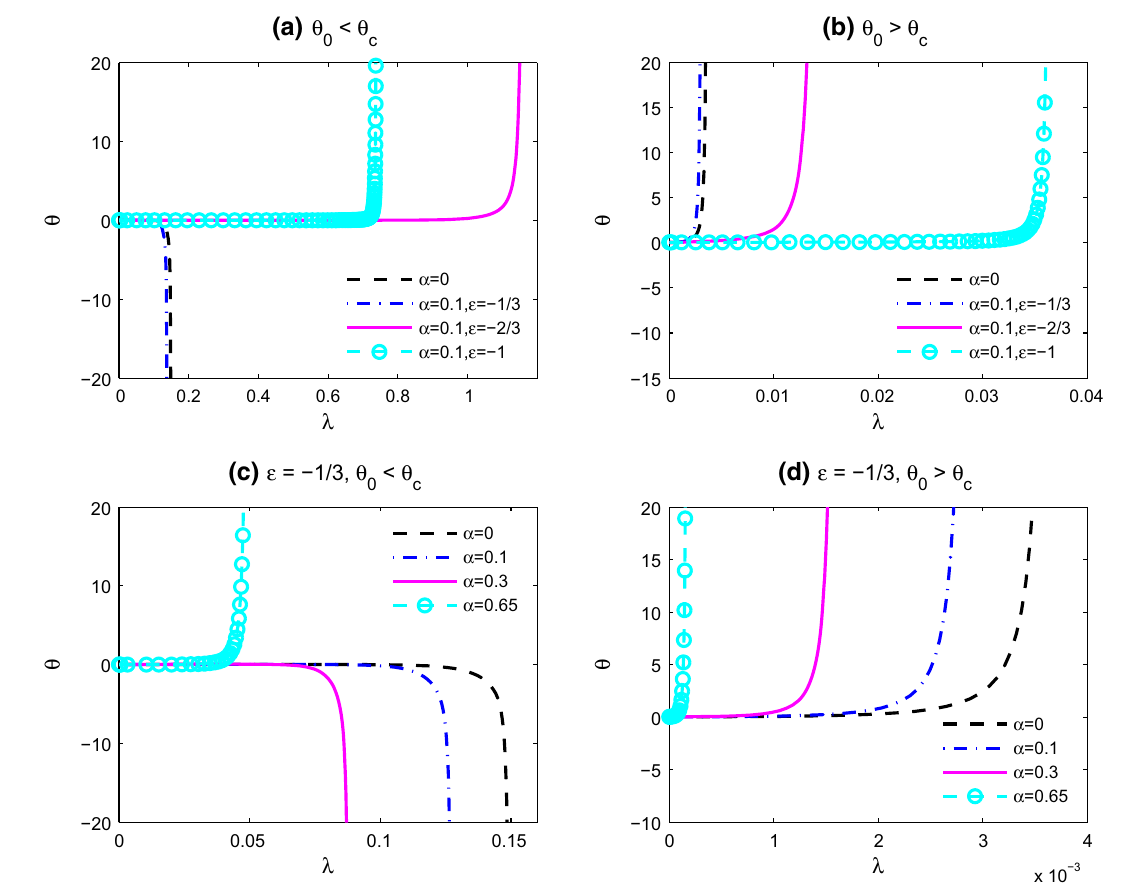
Fig. 7 The evolution of expansion scalar ( θ ) with normalisation constant ( α ) without any initial shear and rotation